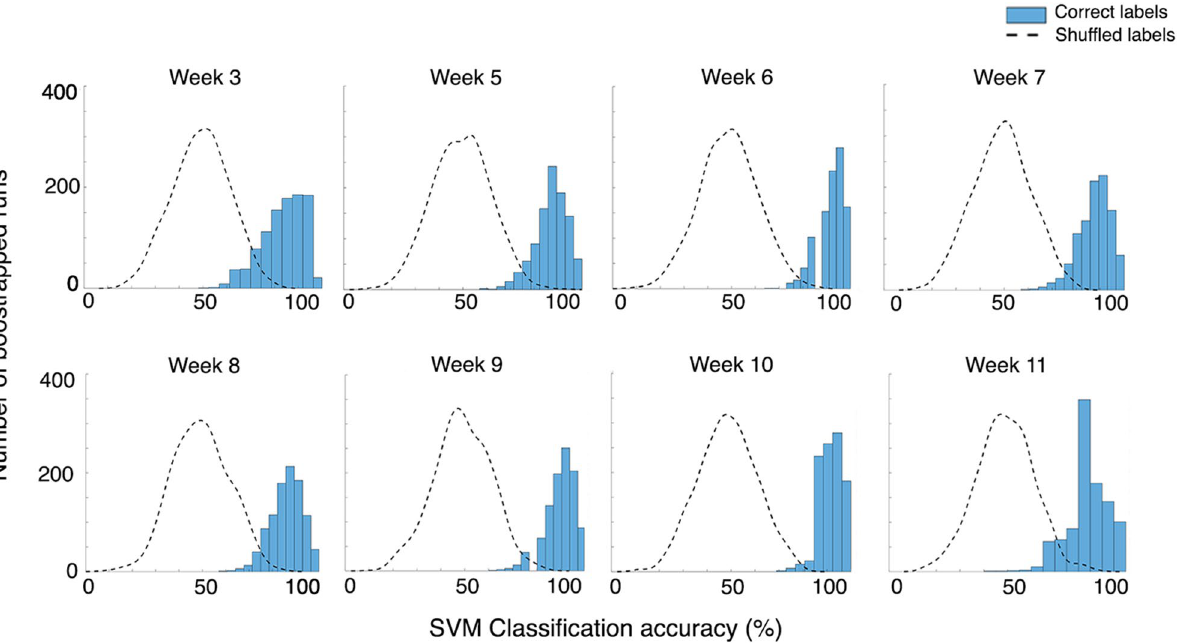
Figure 5. Histogram plots of classification accuracy across 1,000 bootstrapped SVM classifications. The SVM is highly accurate in classifying between α-synuclein and control rats at each week, when all electrodes are included in the analysis. Virtually no classification runs occurred below the 50% baseline. Plots of classification accuracy after shuffling labels are included (dotted lines). Here, accuracies fell around the 50% baseline.